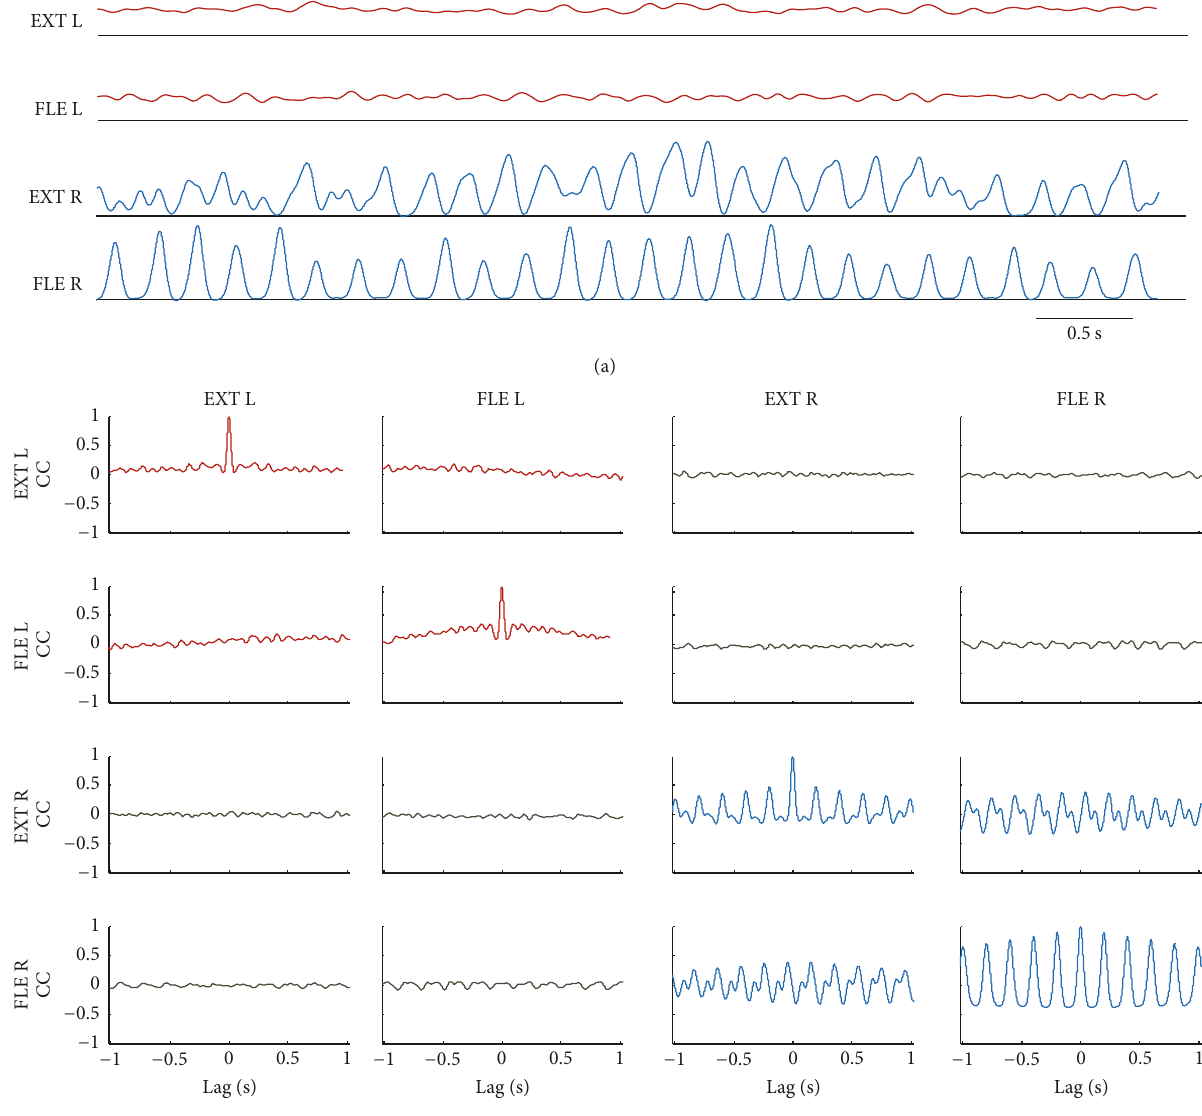
Figure 4: Neural drive to left and right wrist flexors and extensors in representative PD patient during arms outstretched task. (a) Neural drive as estimated by low-pass filtering of cumulative motor unit spike train. Left wrist extensors and flexors exhibit voluntary drive; right wrist extensors and flexors exhibit tremulous drive; (b) cross-correlations (CC) of neural drives; EXT L: left wrist extensors, FLE L: left wrist flexors, EXT R: right wrist extensors, and FLE R: right wrist flexors. The 𝑥 -axis denotes the correlation lag in